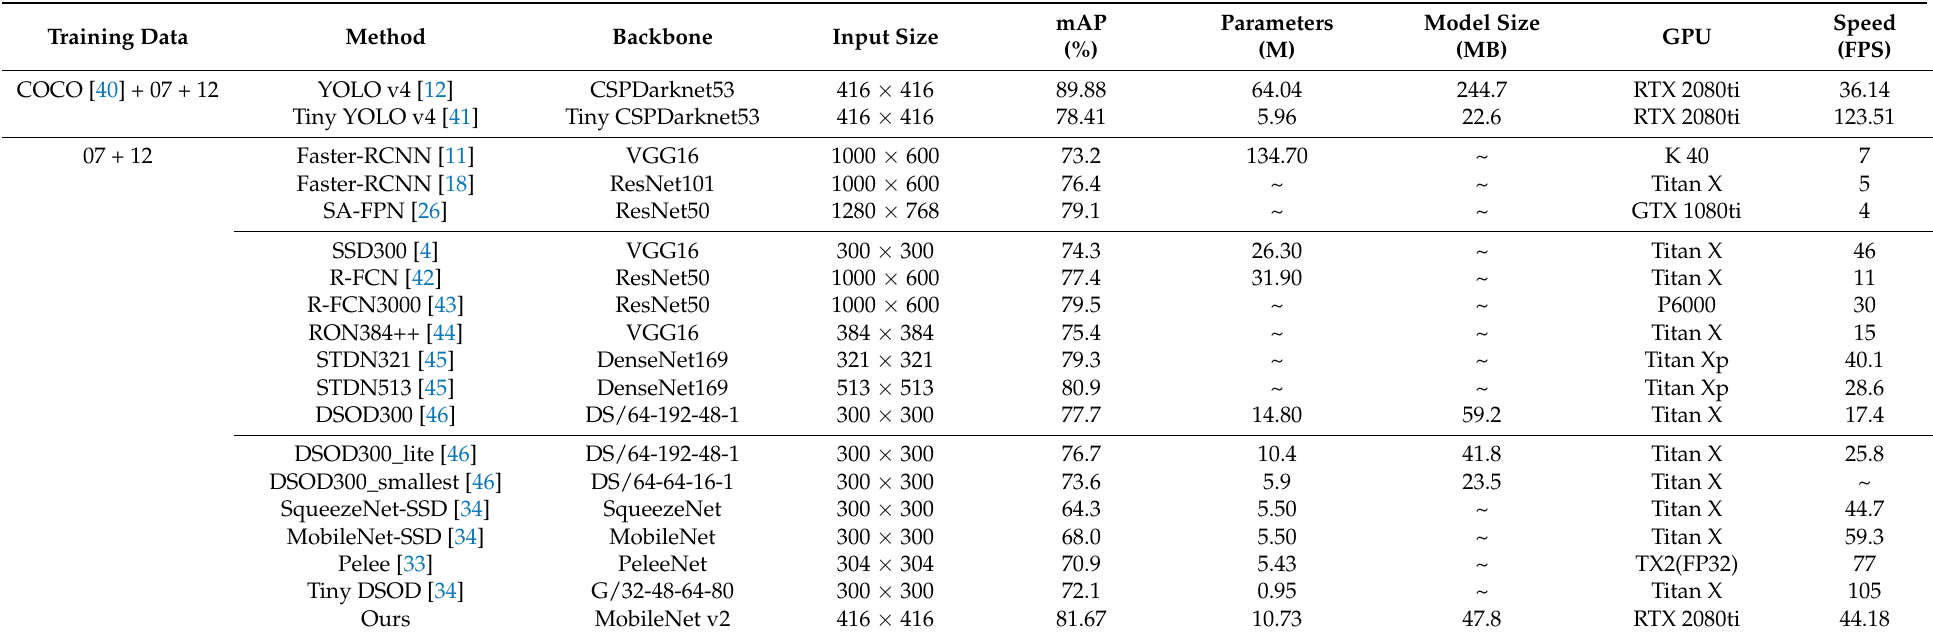
Table 5. The experimental results with different object detection algorithms.